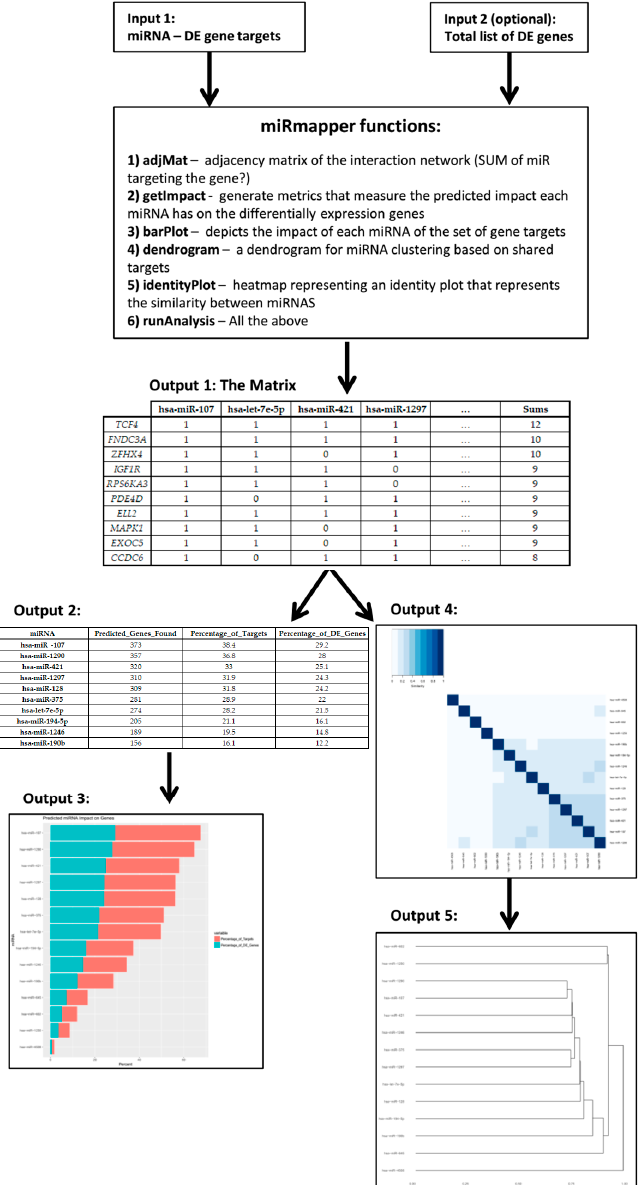
Figure 2. The miRmapper workflow. An miRNA-gene interaction data frame is the required input for the tool (Input 1), additionally a list of total differentially expressed (DE) genes can be used in conjunction (Input 2). The use of the miRmapper functions will provide an adjacency matrix of the miRNA-genes interactions with gene centrality (Output 1), from this a table is generated with the miRNA impact on gene expression (Output 2) and the graphical representation of that impact (Output 3). Also from Output 1, the structural similarity of miRNAs networks is calculated and graphically represented as an identity plot (Output 4) and as a dendogram (Output